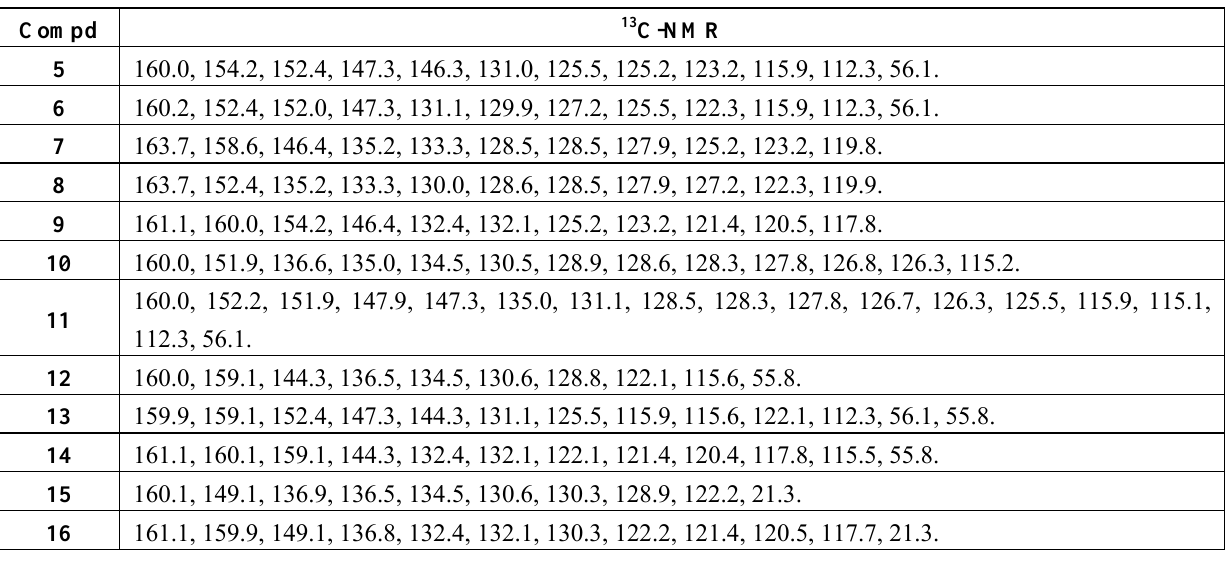
) ( δ , ppm) of azomethines 5 - 16 . 6